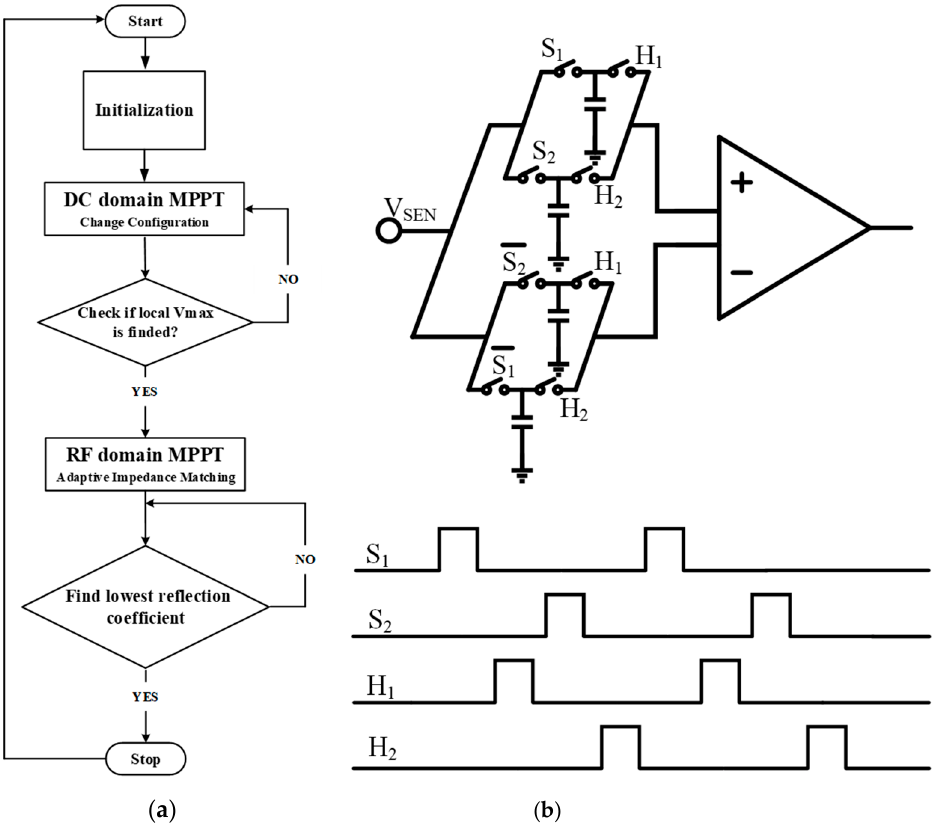
Figure 7. ( a ) The MPPT flow chart and ( b ) two-phase sample and hold circuit.